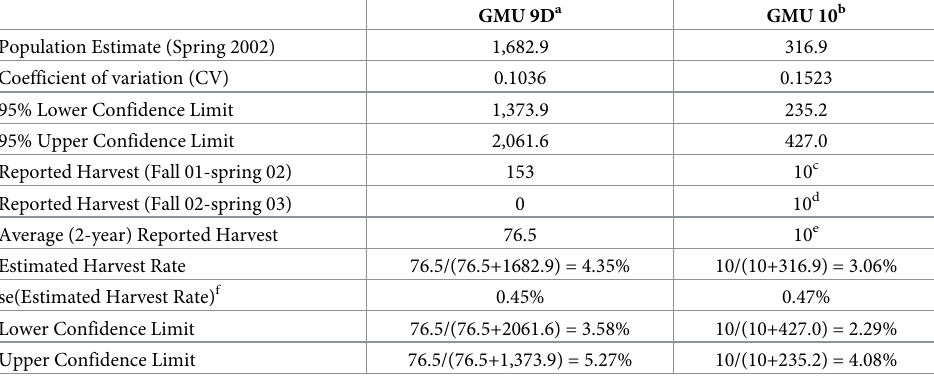
a GMU 9D denotes Game Management Unit 9D, Alaska Department of Fish and Game, and is at the southern end of the Alaska Peninsula. b GMU 10 denotes Game Management Unit 10, Unimak Island only, which is the eastern most Aleutian Island and only island in the archipelago inhabited by brown bears. c Reported harvest used in Estimated Harvest Rate. d Reported harvest not used in Estimated Harvest Rate. e Average reported harvest not used in Estimated Harvest Rate. f Calculated by taking the product of the Population Estimate CV and the Estimated Harvest